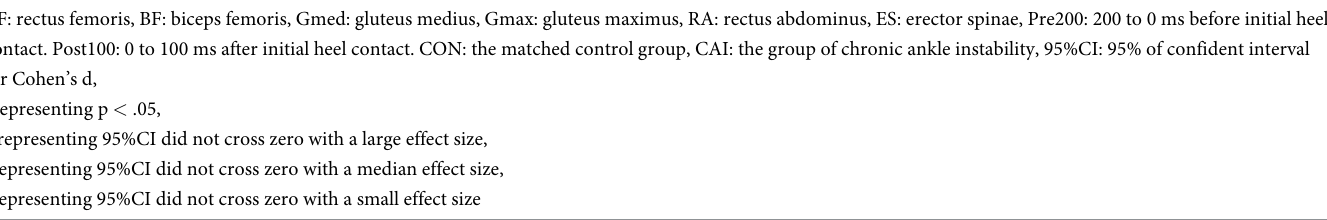
representing 95%CI did not cross zero with a median effect size,